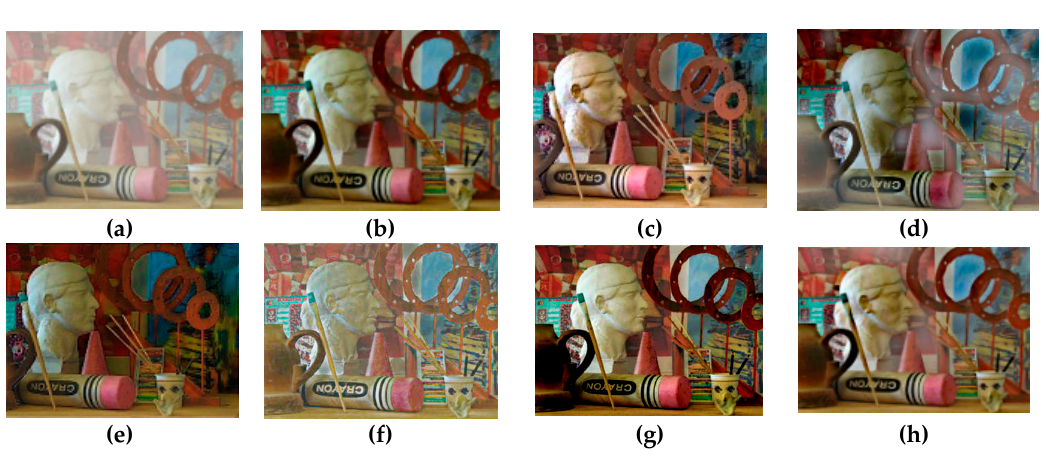
Figure 14. Qualitative comparison on synthetic misty image. ( a ) Synthetic misty image. ( b ) He et al.’s result. ( c ) Meng et al.’s result. ( d ) Ancuti et al.’s result. ( e ) Yu et al.’s result. ( f ) Tarel et al.’s result. ( g ) Choi et al.’s result. ( h ) Our result.